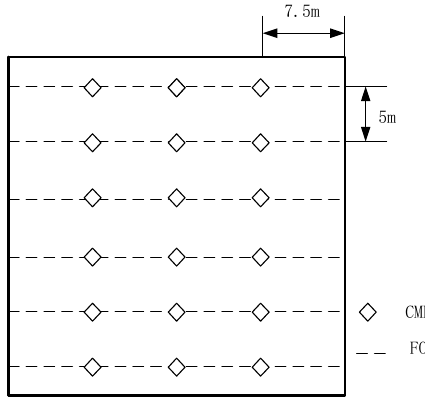
Figure 3. Disposition pattern of measuring points and lines in plots.